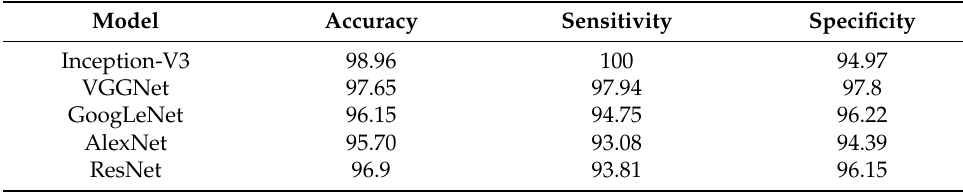
Table 5. Performance of the proposed IGWO-IV3.